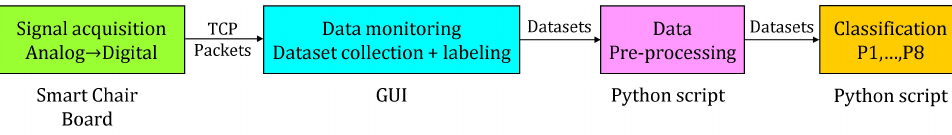
Figure 1. The structure of the proposed Smart chair posture recognition system.